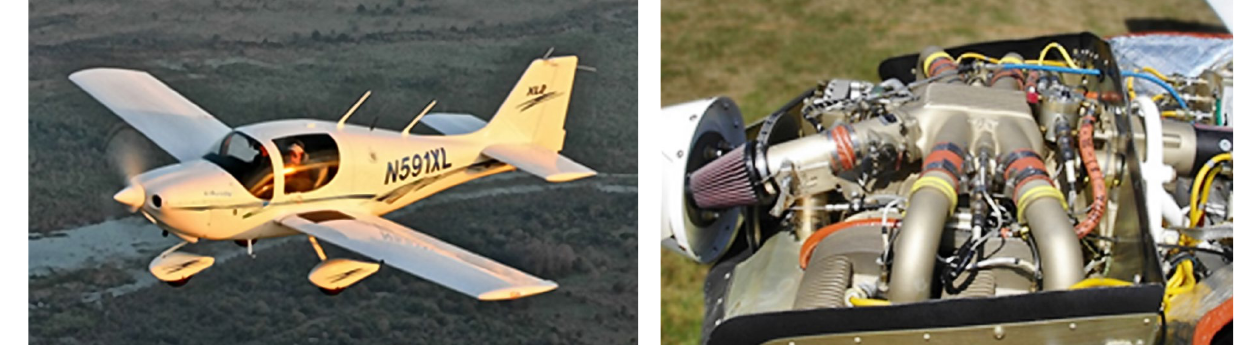
Figure 1. Liberty XL2 in flight (on the left side) and Continental Motors IOF-240-B5B (Ośrodek Kształcenia Lotniczego… 2018) (on the right